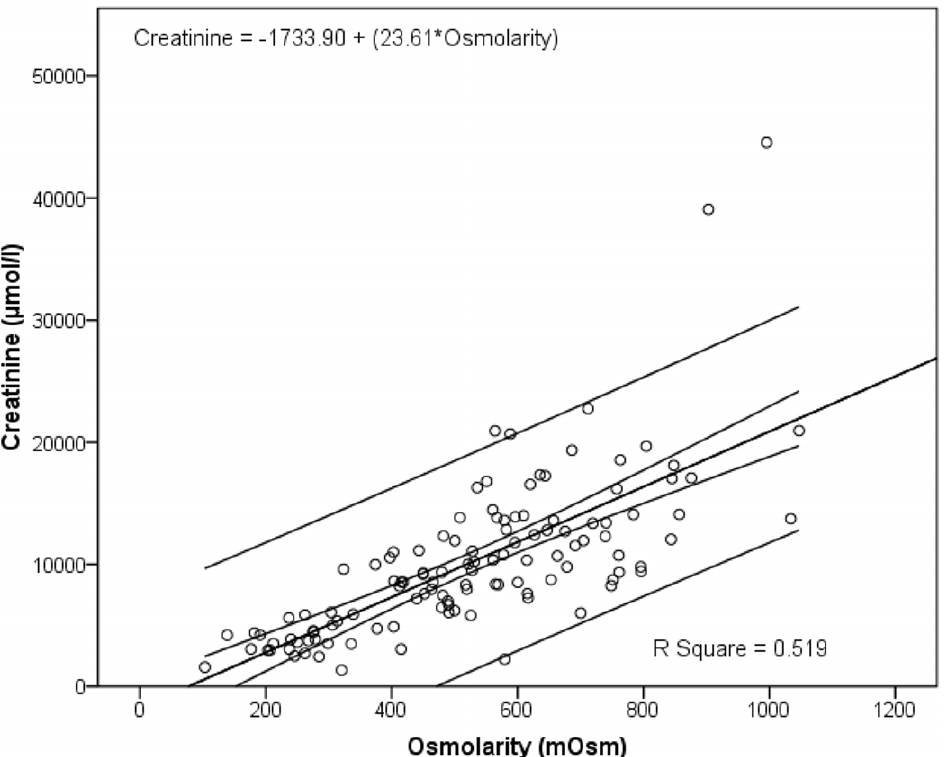
Figure 2. Relationship between osmolarity and creatinine. Triplicate levels of osmolarity and creatinine were measured in urine from 119 hematuric patients. There was a modest relationship between osmolarity and creatinine (R Square=0.519).